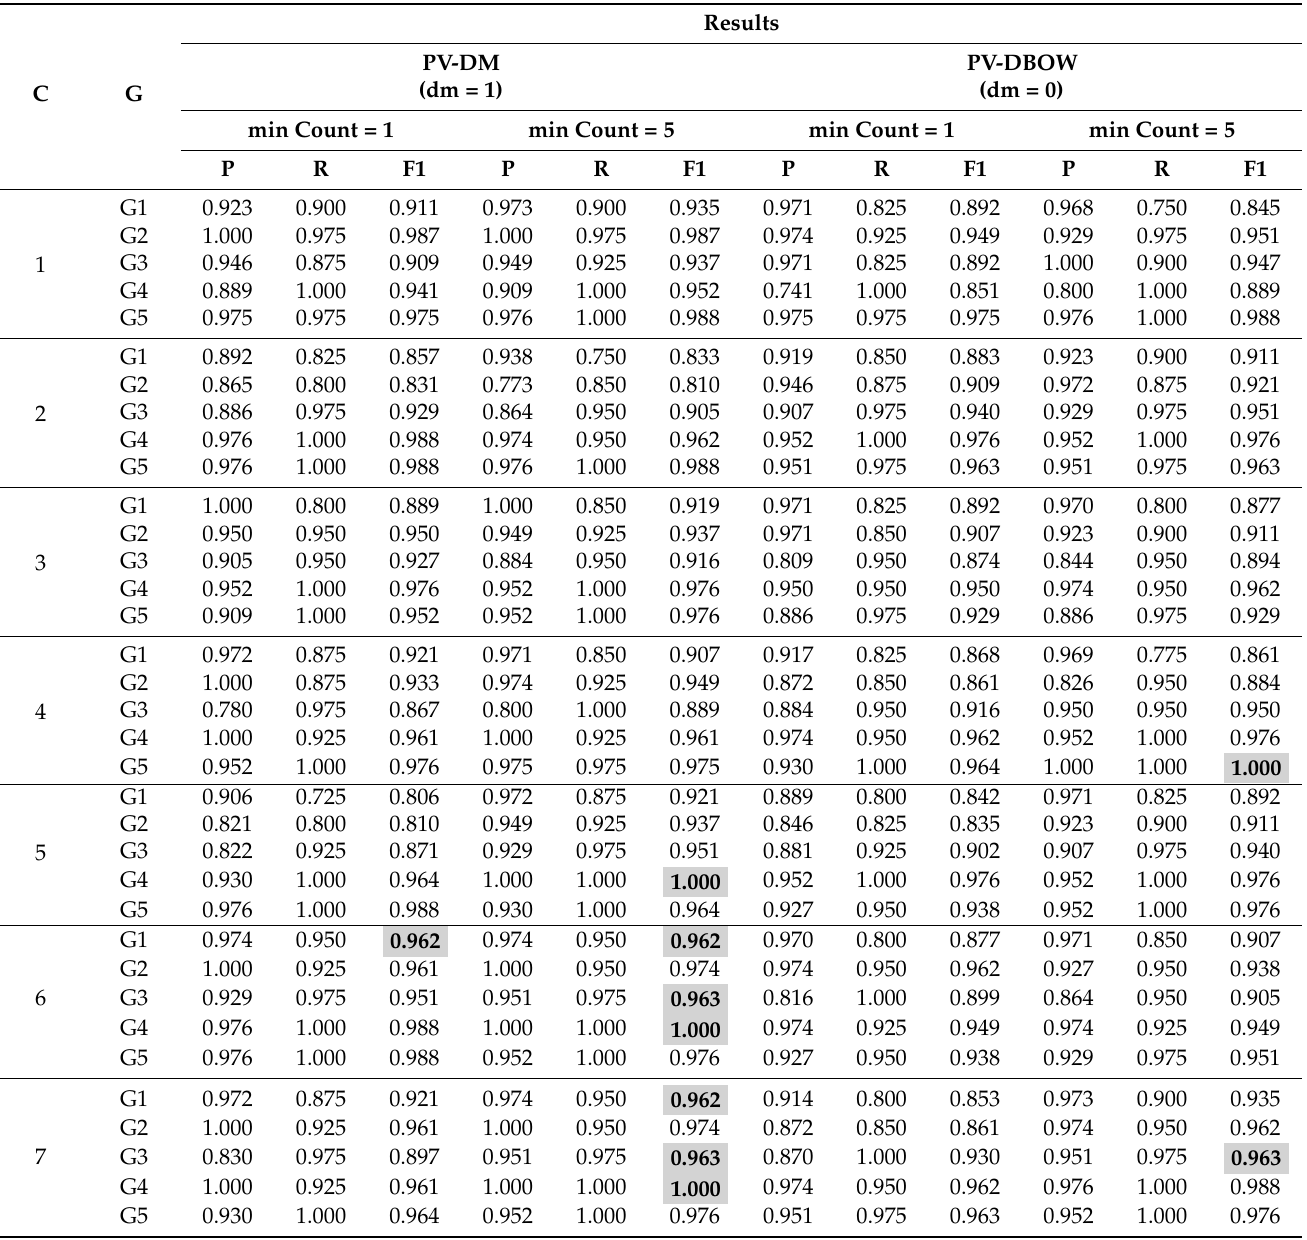
Table A2. Detailed scores of Experimental setup